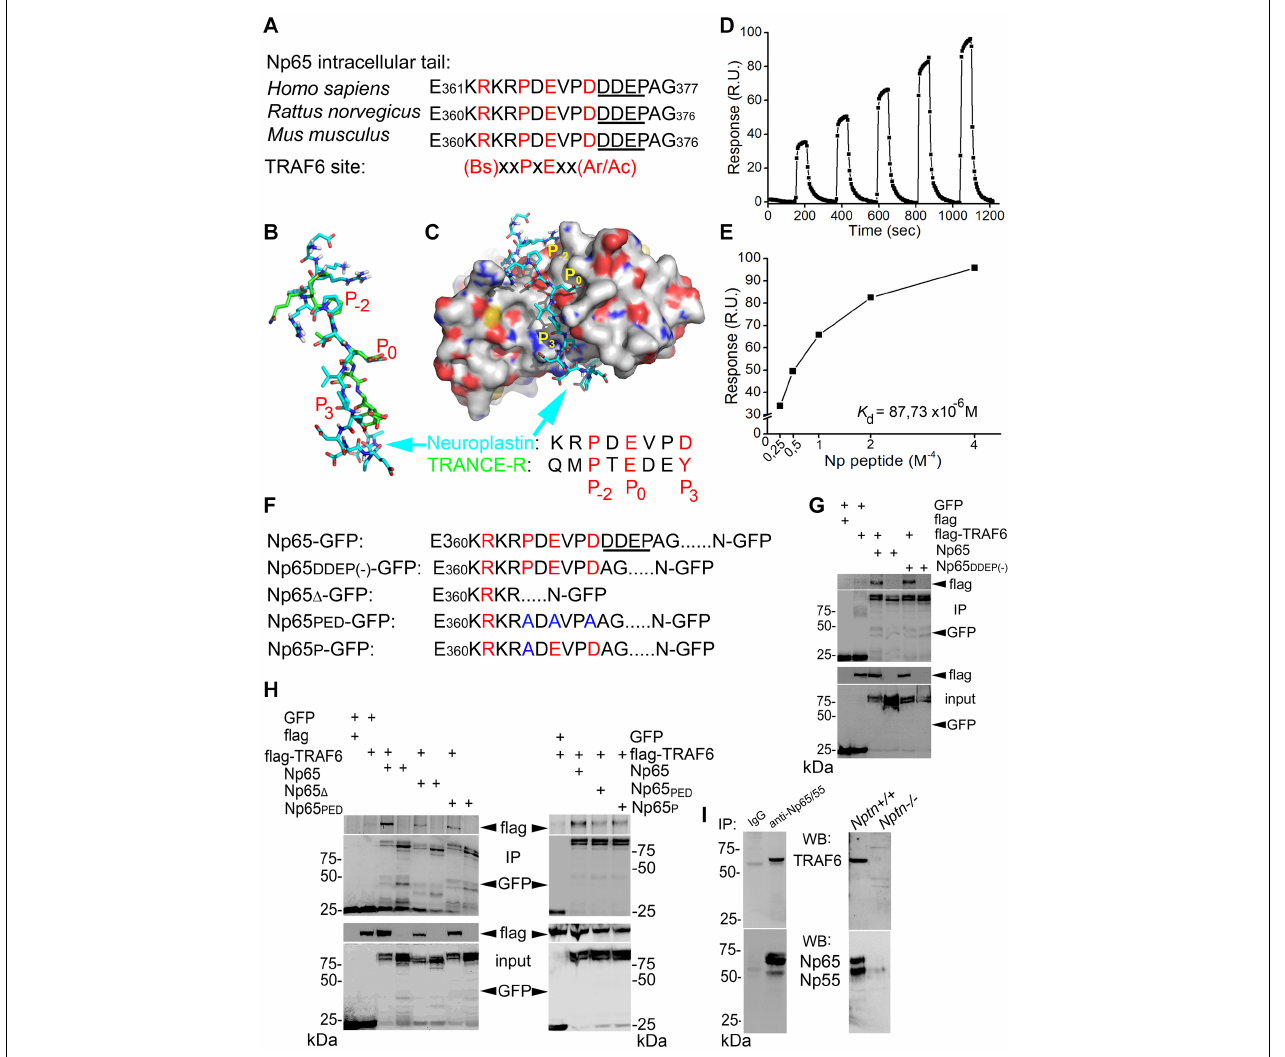
FIGURE 1 | Characterization of the binding of TRAF6 to neuroplastin. (A) Potential TRAF6 binding motif in the intracellular tail of neuroplastin 65 (and identical in neuroplastin 55) fits the canonical and specific motif recognized by TRAF6. The alternatively spliced DDEP sequence is underlined. Bs, Ac, and Ar stand for basic, acidic, and aromatic amino acids, respectively. (B,C) Neuroplastin-TRAF6 binding in silico. (B) Three-dimensional model of the TRAF6 binding motif in the intracellular tail of neuroplastin (cyan) and key amino acids responsible for the binding to TRAF6 fit to the well-known TRAF6 binding motif present in the TRANCE receptor (green). (C) Docking of the TRAF6 binding motif of neuroplastin into the TRAF6 C-domain. Similar to the binding of TRANCE receptor to TRAF6 documented by crystallographic data (Yin et al., 2009), interaction of neuroplastin with TRAF6 would be mediated by the Proline (P) in the position P − 2 Glutamic acid (E) in P0, and Aspartic acid (D) in P 3 . (D,E) Direct binding of the neuroplastin-derived intracellular peptide comprising the TRAF6 binding motif to purified recombinant TRAF6. Time-dependent (D) and concentration-dependent (E) binding curve for the neuroplastin-TRAF6 binding where obtained using surface plasmon resonance. (F–H) Neuroplastin-TRAF6 co-precipitation is drastically decreased by deletion or mutation of key amino acids in the TRAF6 binding motif of neuroplastin. (F) Neuroplastin constructs included in the experiments are listed. (G) HEK cells were co-transfected with constructs encoding either GFP, Np65-GFP or Np65 DDEP ( − ) -GFP and with TRAF6-flag or flag alone for 24 h. Alternatively, (H) HEK cells were co-transfected with GFP, Np65-GFP, Np65 (cid:49) -GFP (TRAF6 binding motif deficient construct), Np65 PED -GFP (containing a TRAF6 binding motif with triple substitution to alanine) or Np65 P -GFP (with single substitution to alanine) and with TRAF6-flag or flag constructs for 24 h. After homogenization, anti-GFP antibody-coupled beads were used to precipitate GFP-tagged complexes. We used anti-Flag or anti-GFP antibodies to detect the proteins as indicated. Representative images from 4-6 independent experiments. (I) Three-weeks old rat forebrains (left panel) and hippocampus from 2 weeks-old Nptn + / + and Nptn − / − mice (right panel) were lysed and homogenized with RIPA lysis buffer and incubated with a KO-controlled antibody recognizing all neuroplastin isoforms raised in rabbit or pre-immune IgG from rabbit for 24 h at 4 ◦ C. Precipitated proteins were resolved by SDS-PAGE and immunoblotted with a KO-controlled pan anti-Np65/55 antibody from sheep or an anti-TRAF6 antibody from mouse (see section Materials and